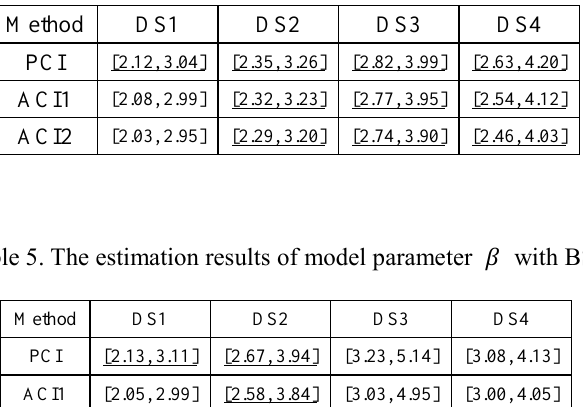
Table 4. The estimation results of model parameter 𝛽 with BS1